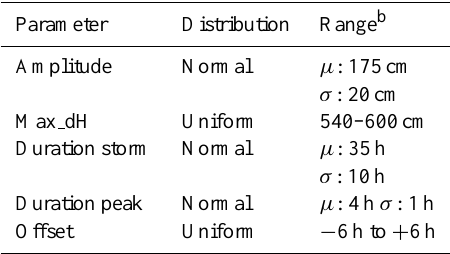
Table 1. Distribution and range of uncertainty estimates for param- eters related to the storm surge water level a